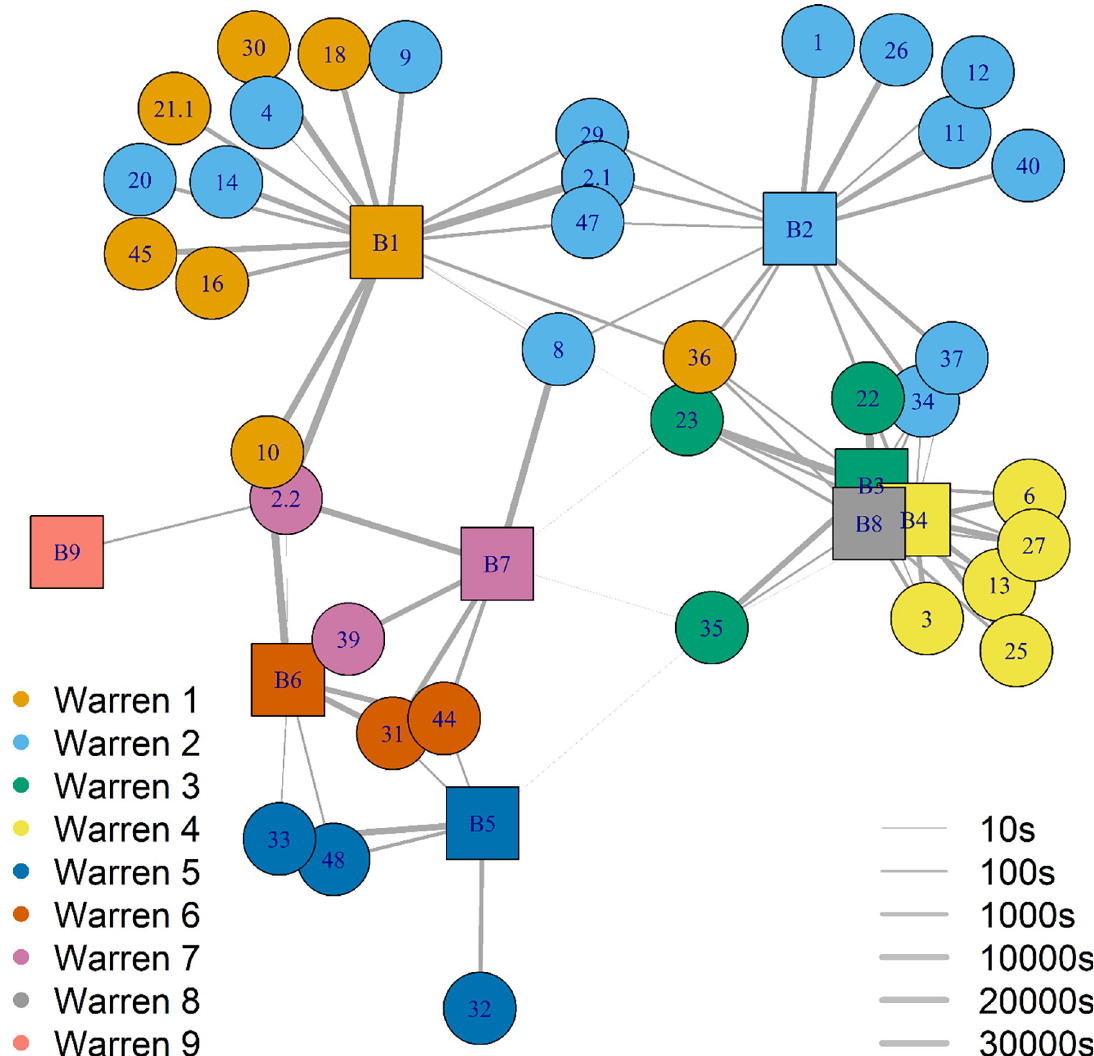
Fig 5. A network of logger pairings with base stations. Nodes (circles indicating logger identification number) represent rabbits and lines between nodes indicate the strength of the pairing. Edge thickness (10–30,000 seconds) is proportional to total time in pairing (log 10 scale). Nodes and squares are coloured according to the base station location (coloured squares, prefix ‘B’, n = 9) and warren of capture (n = 7) for the loggers. Base stations are numbered as per each warren number.